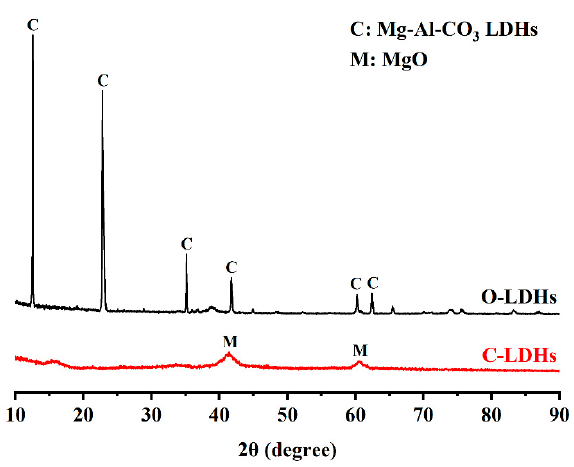
Figure 2. XRD patterns of O-LDHs and